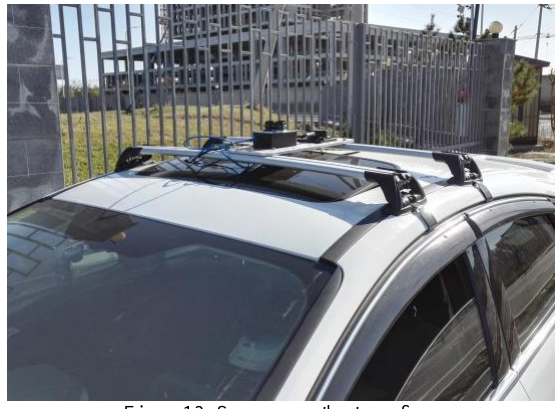
Figure13. Sensors on the top of